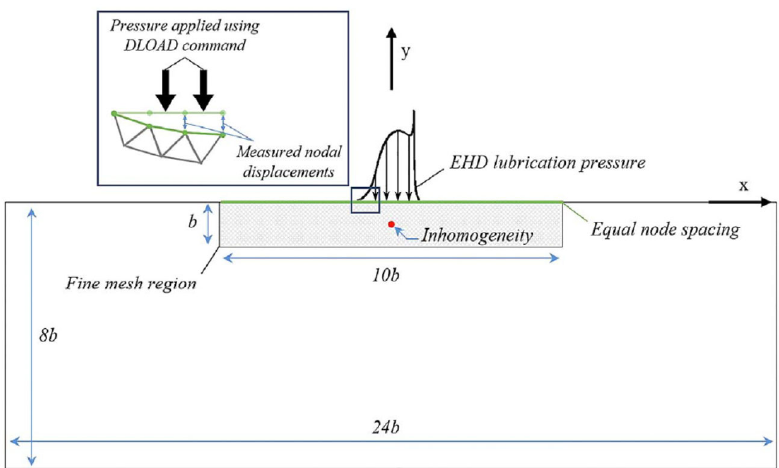
Fig. 55 2D FE domain schematic with dimensions, load application, and surface deflection measurement (EHD lubrication pressure half width may vary based on the prescribed load) [860]. Reproduced with permission from Ref. [860], © American Society of Mechnaical